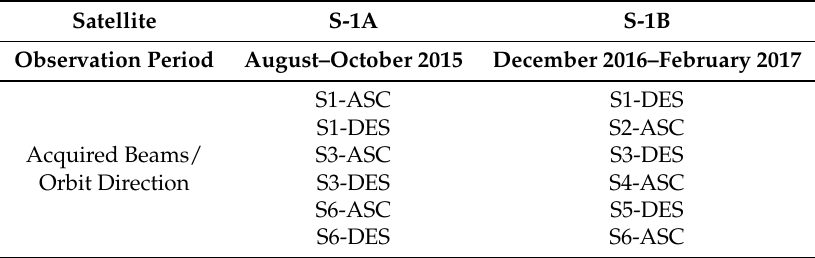
Table 1. Stripmap mode observation period over the DLR calibration site.